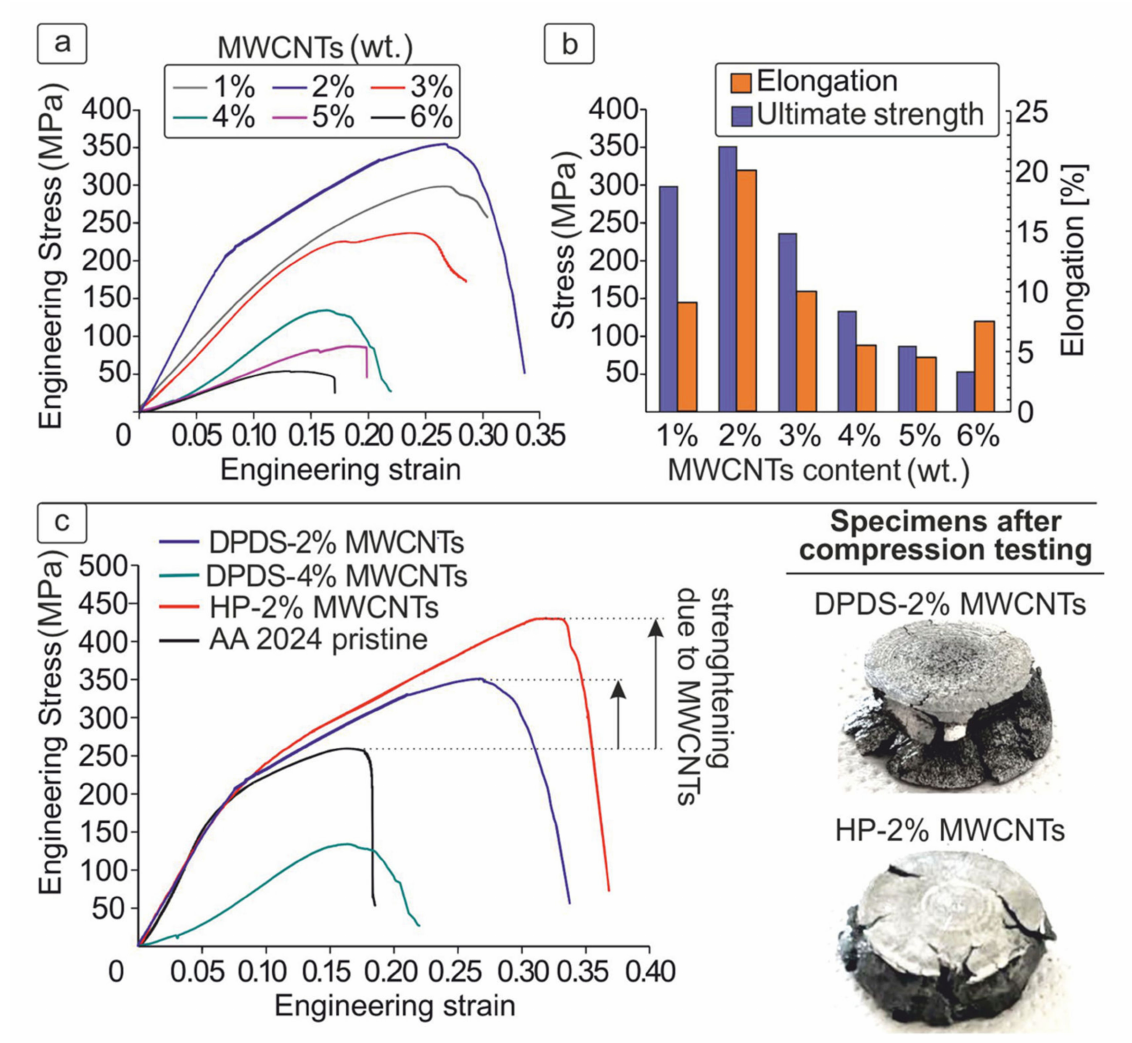
Figure 6. ( a ) Compressive stress–strain curves and ( b ) strength and elongation values for various AA2024 nanocomposites with addition of 1, 2, 3, 4, 5, 6 wt.% MWCNTs produced with DPDS method. ( c ) Compressive stress–strain curves of the pristine AA2024 and several AA2024-MWCNTs produced under different conditions along with indicative photos of specimens post